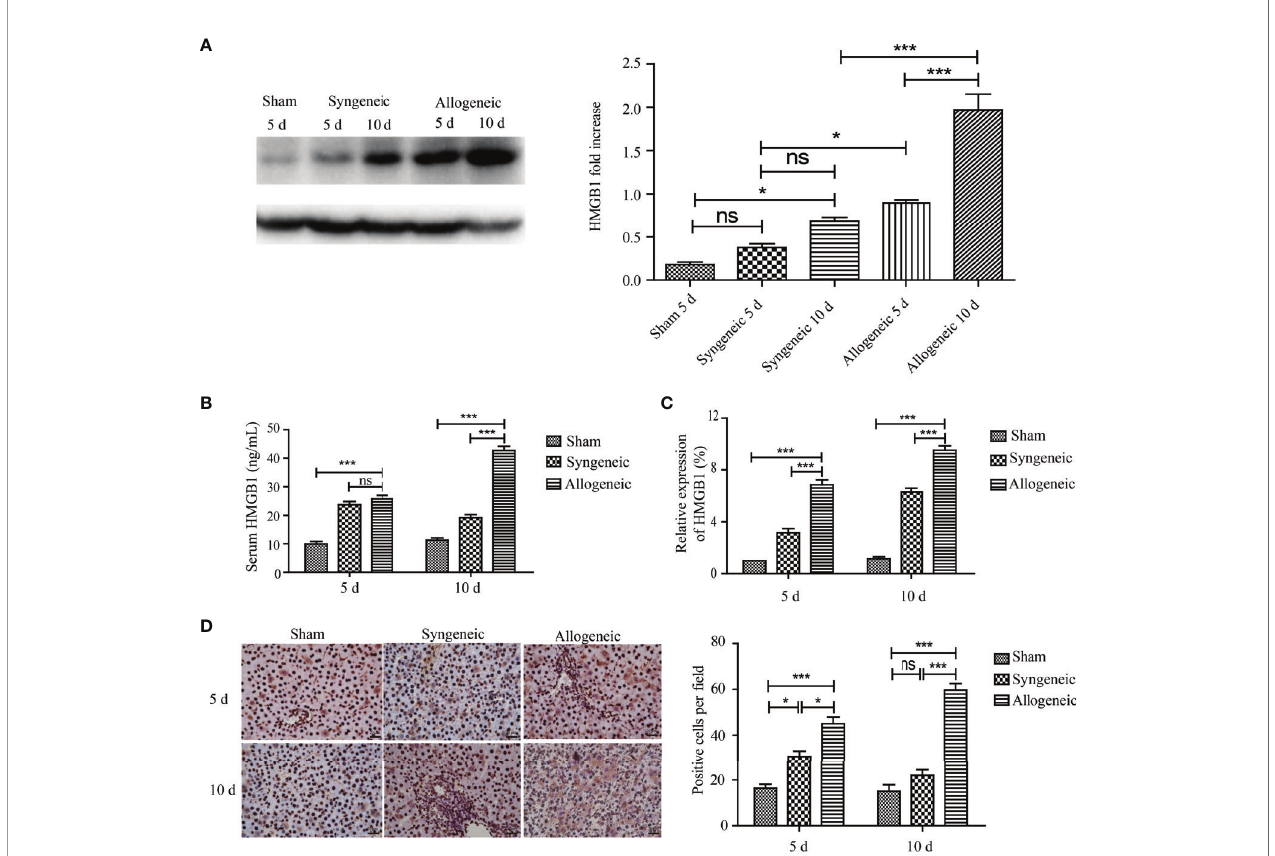
FIGURE 3 | The expression of HMGB1 in liver grafts. After liver graft tissues and serum samples were collected from recipient rats at 5 and 10 d after transplantation, the HMGB1 mRNA and protein levels were measured by ELISA, qRT-PCR, and IHC. (A) Expression of HMGB1 protein in liver grafts tissues was evaluated by western blot and GAPDH was used as a control. HMGB1 in the allogeneic and syngeneic groups was increased with time, and its expression in the allogeneic group was higher than that in the syngeneic group at all timepoints post surgery. (B, C) HMGB1 mRNA and protein levels detected by ELISA and qRT- PCR. HMGB1 mRNA and protein levels in the allogeneic group were highest among the three groups. (D) HMGB1 protein detected by immunohistochemistry (magni fi cation, ×400). HMGB1 positive cells were counted with Image pro plus and are shown in the right panel. Numbers of nuclear- and cytoplasm-positive cells were highest in the allogeneic group at 5 and 10 d after transplantation compared with the other groups. All experiments were performed three times and data are presented as the mean ± SD. * p < 0.05, *** p < 0.001; ns, not signi fi